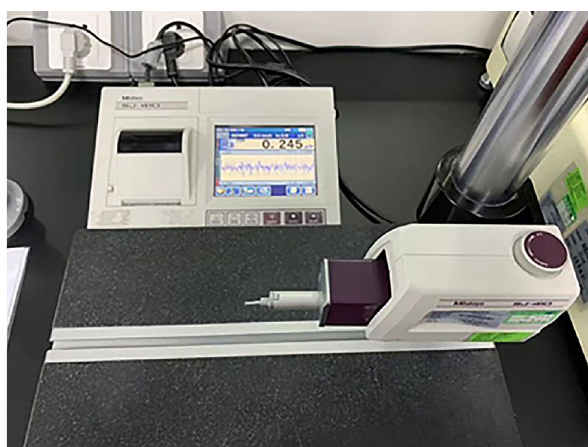
Figure 7. The point needle instrument.